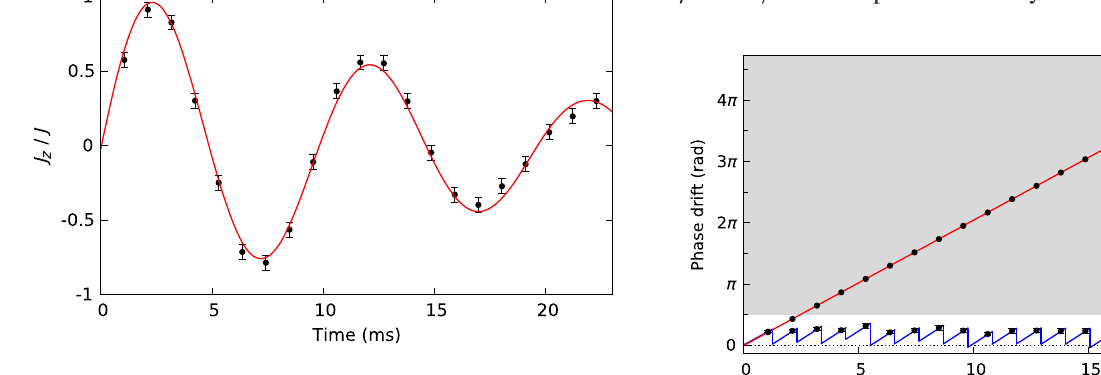
FIG. 3. Coherence-preserving measurement of the relative phase between the LO and the atomic superposition. Real-time measurement of the normalized population difference to which the relative phase φ between the local oscillator and the atomic superposition state is periodically mapped via microwave rotation pulses. The phase precession is induced by setting the LO frequency 100 Hz off the nominal atomic transition frequency. The experimental points are fitted with a sinusoidal evolution, damped because of the decoherence induced by the J ment and the residual differential light shift on the clock transition.